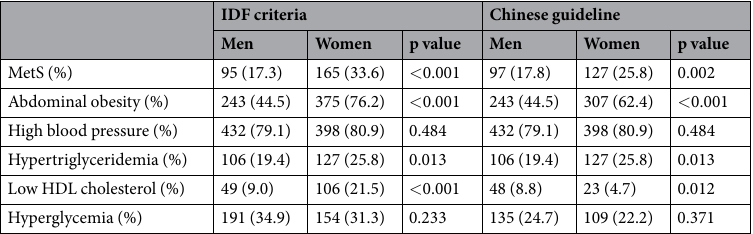
Table 2. Estimated prevalences of metabolic syndrome and its components in community very elderly Chinese in Chengdu. HDL: high-density lipoprotein,IDF: international diabetes federation, MetS: metabolic